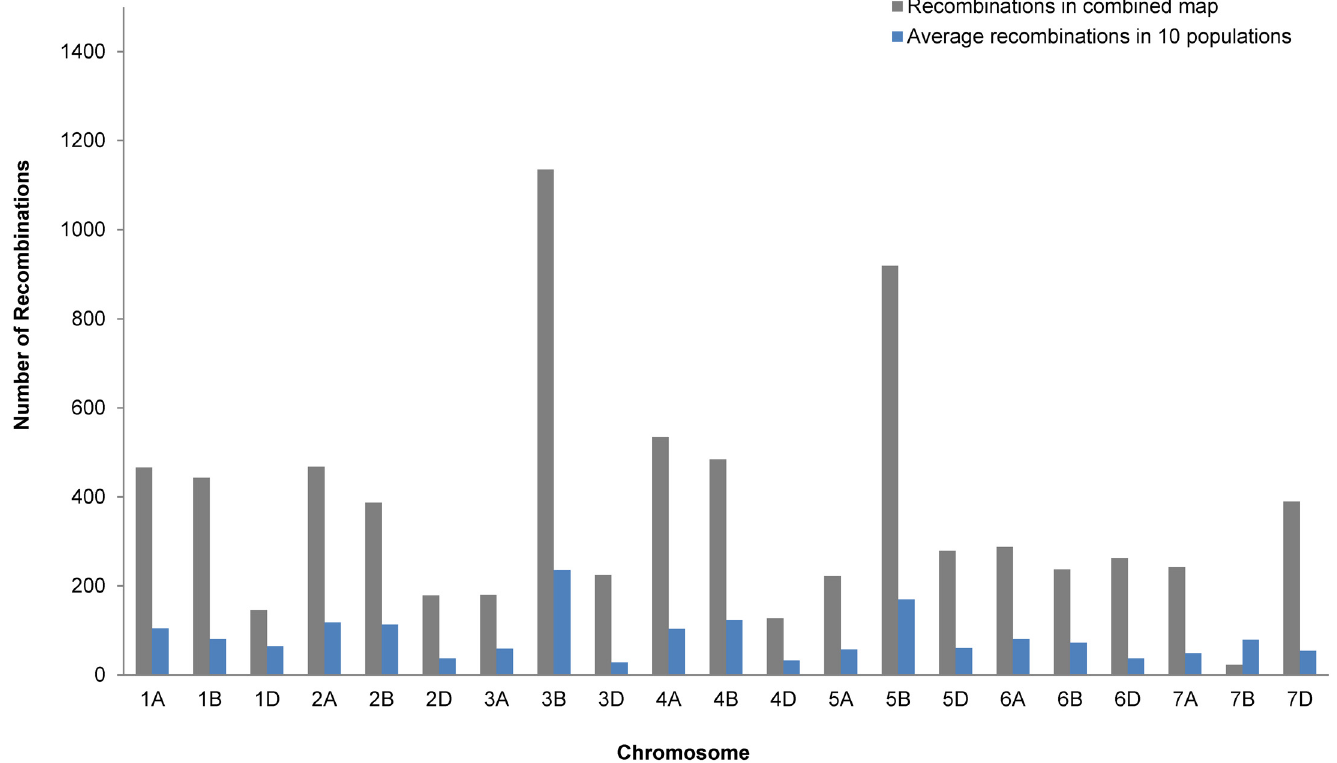
Fig 3. Number of recombination events per chromosome in the joint map (gray bar) relative to the average number of recombinations per chromosome in all 10